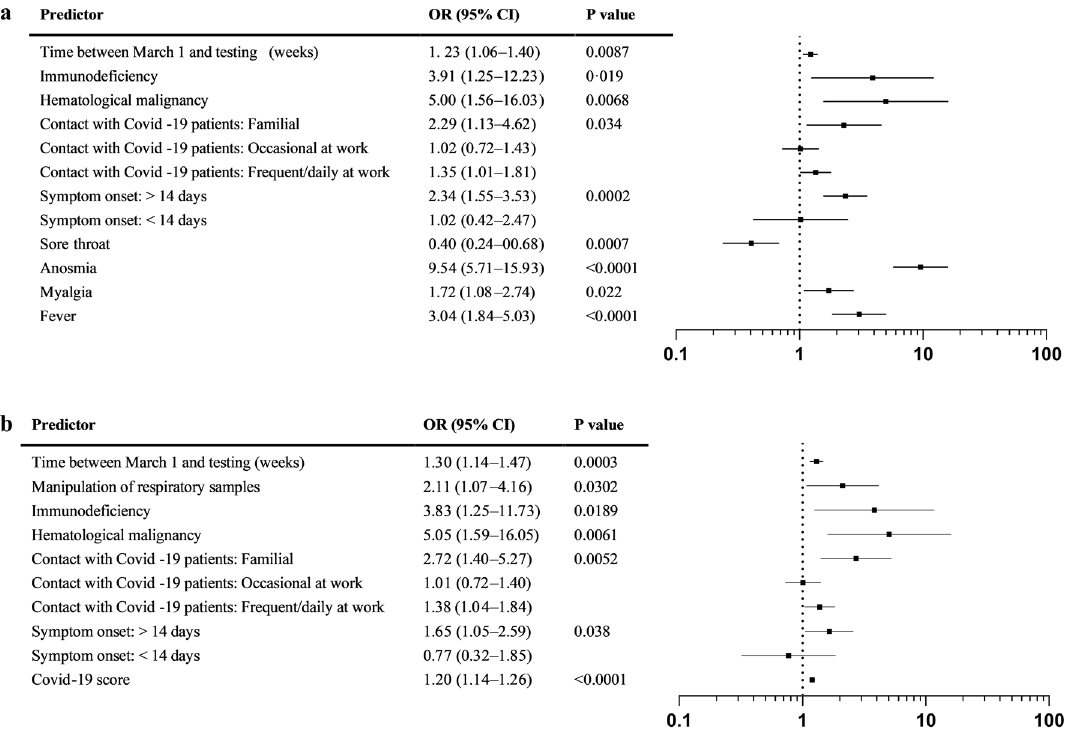
Figure 1. Predictors of SARS-Cov-2 positive serology (IgG DiaSorin) in phase 1 in multivariate analyses. ( a ) Binary model with subject characteristics, exposure and detailed symptoms. ( b ) Binary model with subject characteristics, exposure and COVID-19 score.